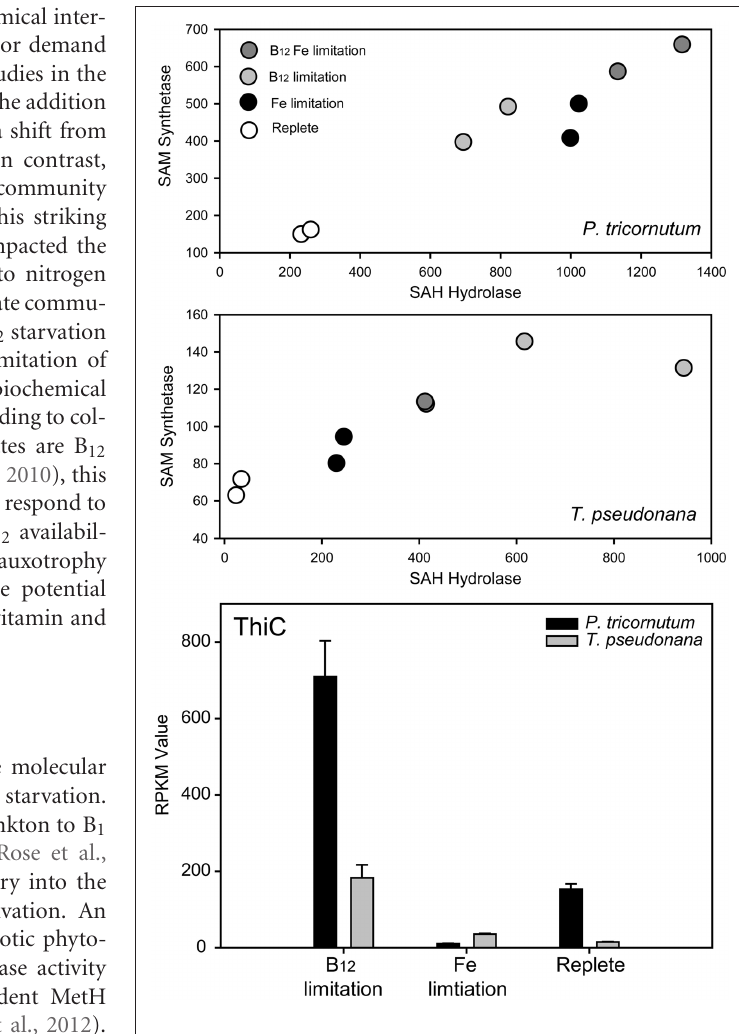
FIGURE 2 | Evidence from Bertrand et al., 2012 that AdoMet SAM starvation is an important consequence of B 12 deprivation, with implications for thiamine biosynthesis. SAM synthetase (Tp 39946, Pt 18319) converts methionine and ATP to SAM. SAM, after use for methylation reactions, is converted to S-adenosylhomocysteine (SAH). SAH can act as an inhibitor to methylation reactions because of its high affinity for most methyltranserfases. SAH hydrolase (Tp 28496; Pt bd 913) catalyzes the reversible interconversion of SAH to homocysteine and adenosine. The expression of the genes encoding these proteins in two diatoms appears to correlate. RPKM (Reads Per Kilobase of exon model per Million mapped reads) gene expression values are plotted against each other for each of eight samples in two diatoms, duplicates of replete, low B 12 , low B 12 with low iron, and low iron alone. Expression under iron limited conditions was examined along with B 12 to verify whether changes induced were likely a general stress response or more specific to the vitamin. In both diatoms, cells grown under nutrient replete conditions express these genes at the lowest level. Iron and B 12 availability both influence the expression of these genes, with B 12 having a greater impact of gene expression the B 12 requiring diatom T. pseudonana . ThiC is a SAM-dependent protein required for pyrimidine moiety synthesis in thiamine biosynthesis. The expression of genes encoding ThiC in both these diatoms is elevated under low B 12 availability and not under low iron availability, suggesting that thiamine biosynthesis, and B 12 availability may be linked in these diatoms, potentially through B 12 impacts on SAM